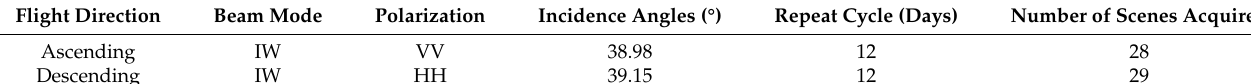
Table 1. Characteristics of the Sentinel-1 images used in this work.